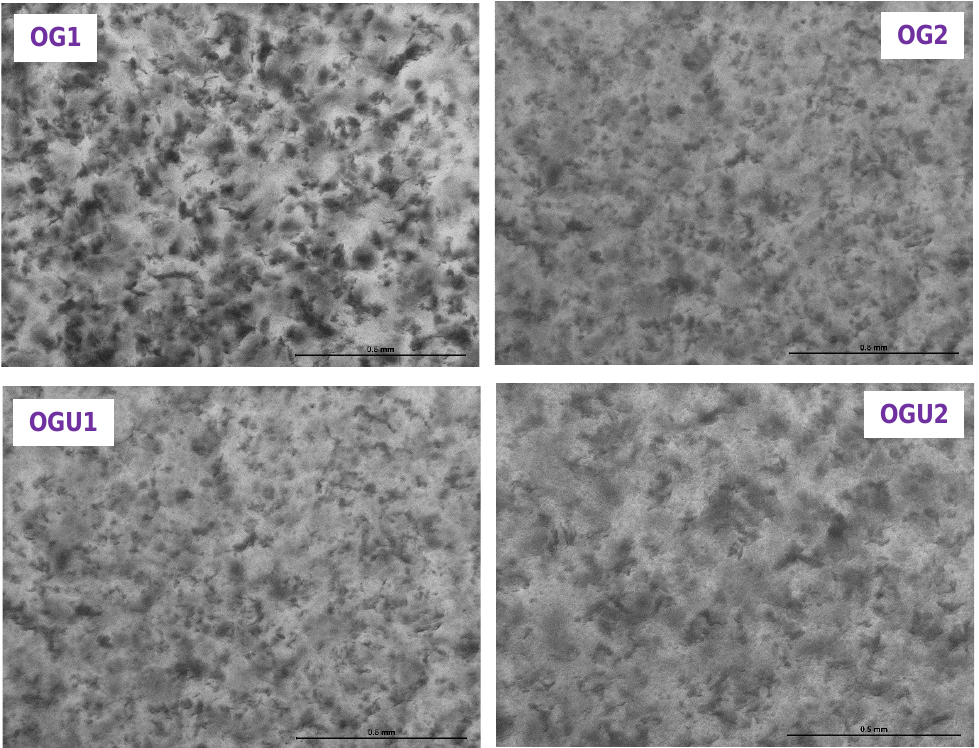
Figure 6. Microscopic observation of palm oil-based oleogels prepared with different concentrations of carnauba wax and the ultrasonication process.